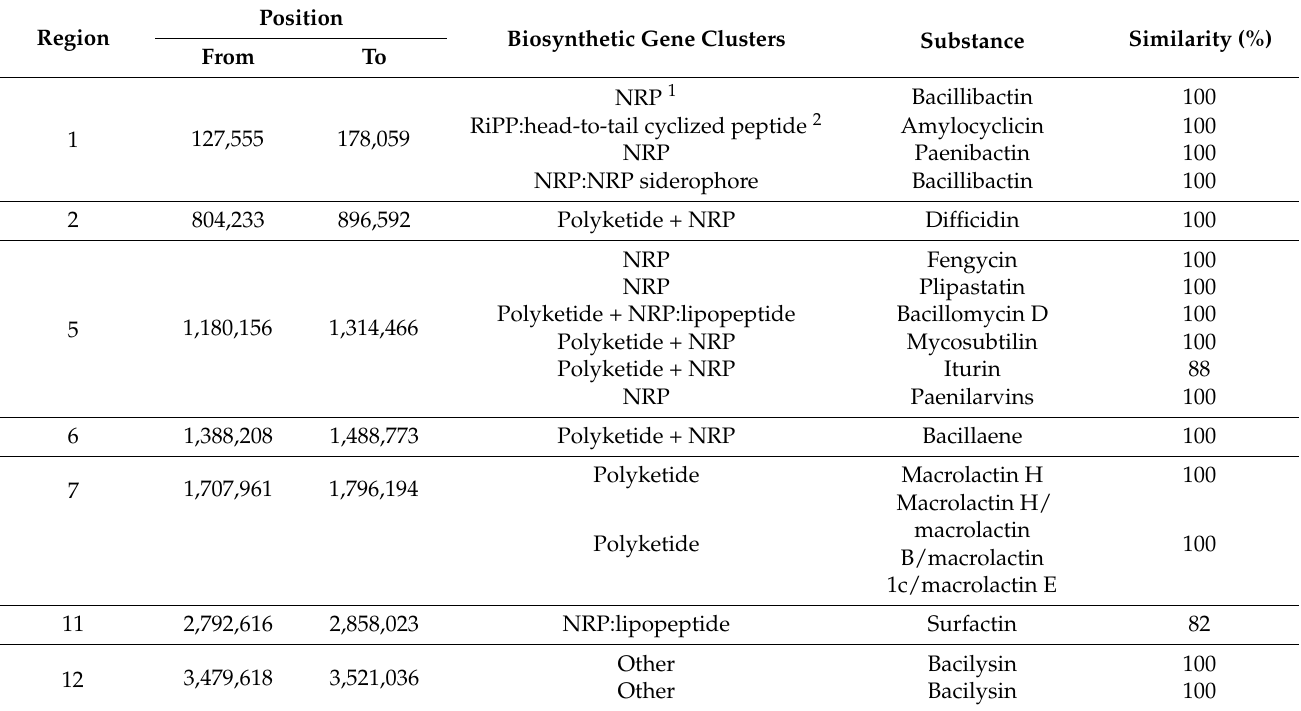
Table 6. The secondary metabolite gene clusters in the isolate B1 obtained using anti-SMASH. Position Region Biosynthetic Gene Clusters Substance Similarity (%) From To